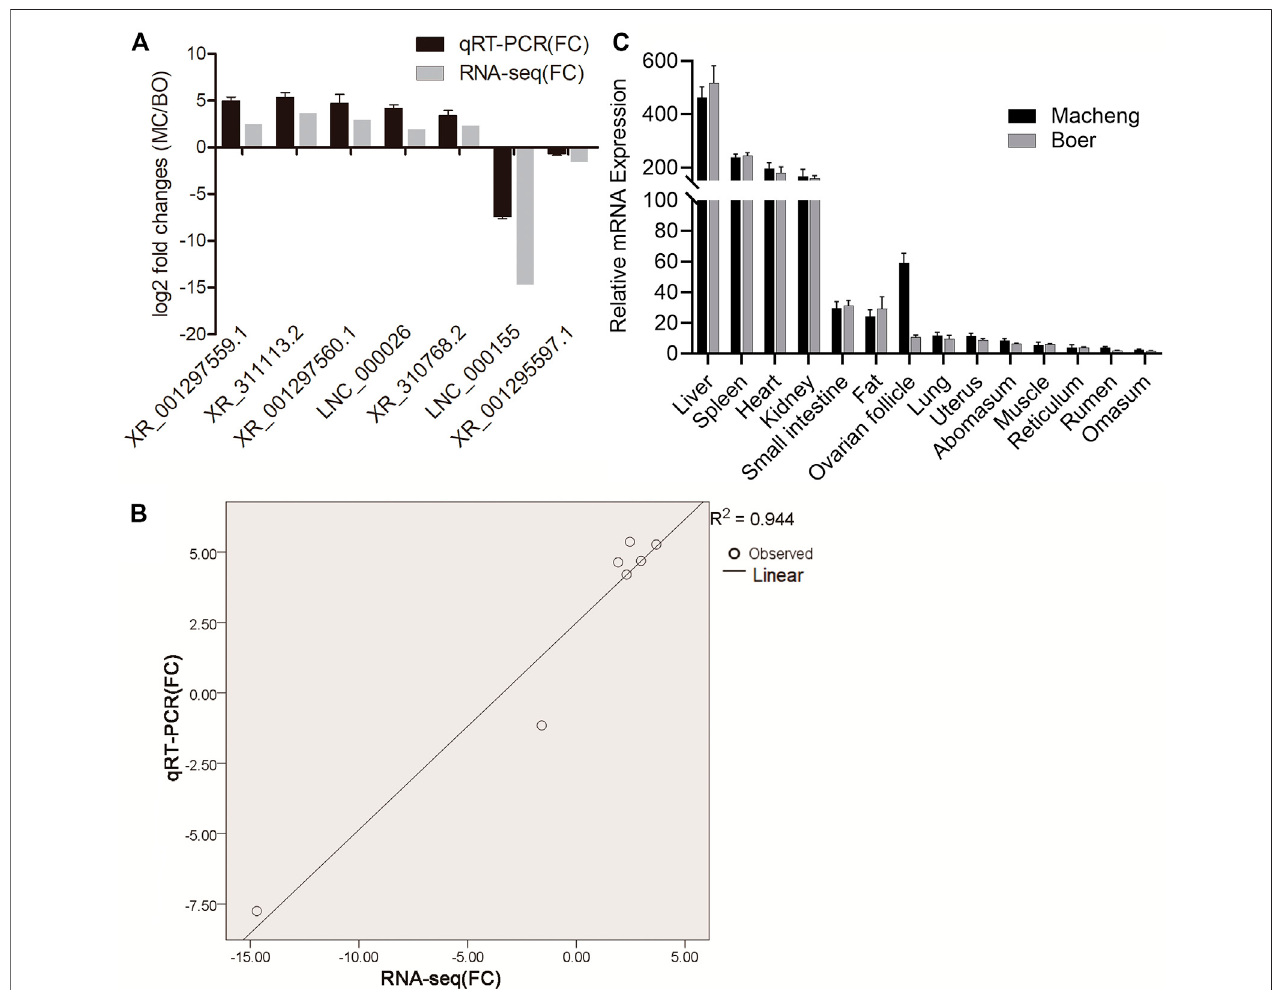
FIGURE3| ValidationofselectedlncRNAsandmRNAsusingqRT-PCR. (A) FoldchangesintherelativeexpressionoflncRNAs,asassessedbyqRT-PCR.Results of the comparison of the seven lncRNAs using qRT-PCR and RNA-seq. The vertical axis indicates the mean fold change (log2-fold change) of each lncRNA. (B) Correlation analysis of the fold changes between qRT-PCR and RNA-seq. (C) Relative expression of lncRNAs. Expression pro fi le of lncRNA XR_311113.2 in 14 tissues of Macheng and Boer goat expressed as the mean ± SD. Data were normalized to the reference gene ( β